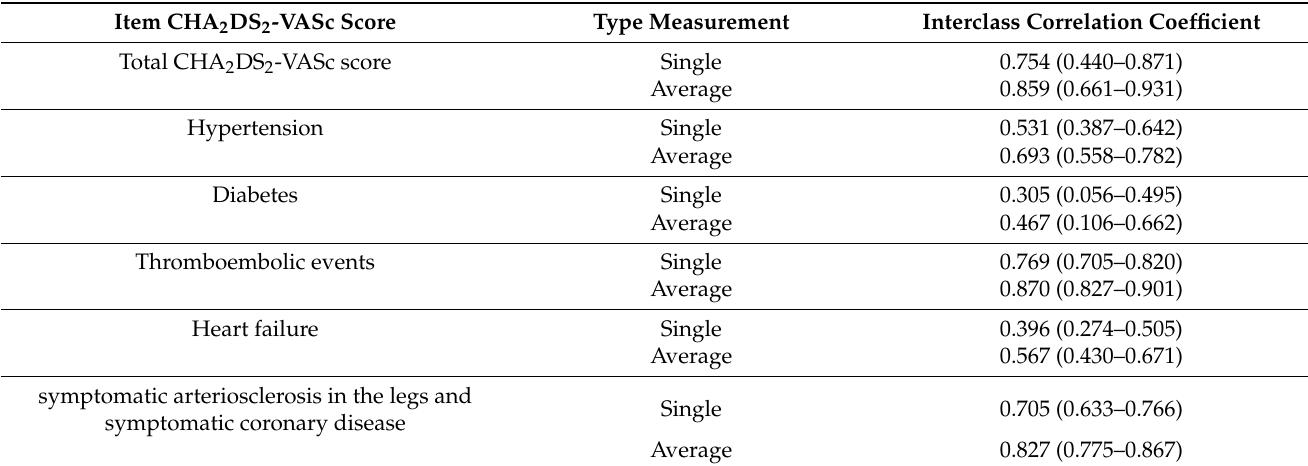
Table 3. Interclass Correlation Coefficient (95%-CI); aCDSS vs mCDSS CHA 2 DS 2 -VASc